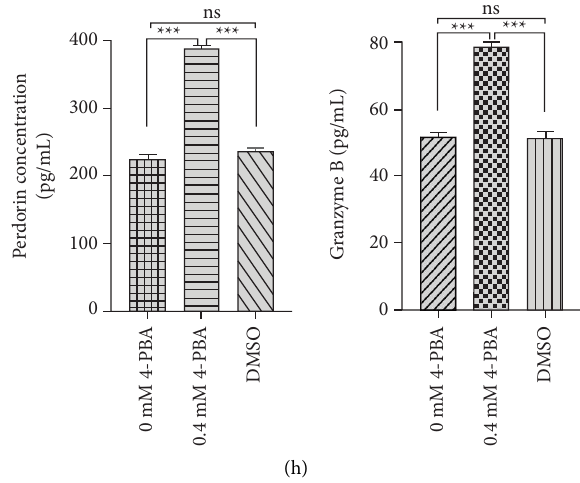
Figure 3: Activation of ER stress induces CTLs depletion. (a) CTTL-2 cells were cocultured with Hepa1-6 cells for one day. Different concentrations of TM (0, 1, 2, and 4 μ M) were added to CTTL-2 cells and cultured for 1 day. Western blotting analysis was used to determine GRP78 levels. (b) Cells were treated with TM (0 and 4 μ M), and changes in ER morphology were analyzed by electron microscopy (scale bar � 2 μ m). (c) CTTL-2 cells were cocultured with Hepa1-6 cells for one day. Different concentrations of 4-PBA (0, 0.1, 0.2 and 0.4mM) were added to CTTL-2cells and cultured for one day. The expression of GRP78 was analyzed by western blotting. (d) Cells were treated with 4-PBA (0 and 0.4mM), and ER morphology was examined by electron microscopy. (e) CTLL-2 cells were treated with TM, and western blotting was used to analyze PD-1 and TIM-3 expression. (f) ELISA analysis of PRF1 and GzmB expression. (g) CTLL-2 cells were treated with 4-PBA, and PD-1 and TIM-3 expression levels were measured by western blotting. (h) ELISA was used to detect the expression of PRF1 and GzmB. Data are presented as the mean ± SD. ∗∗∗ P < 0 . 001, ns indicates no statistical significance.